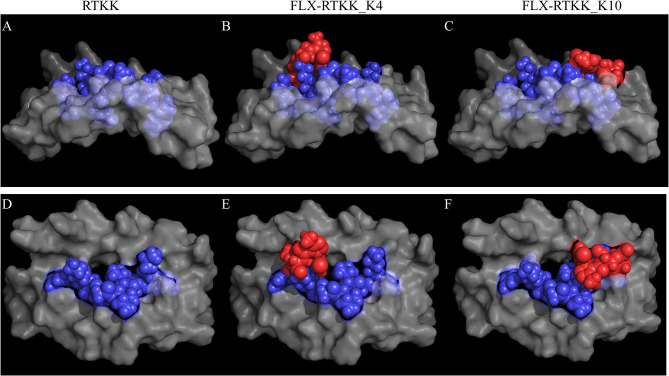

In silico prediction of the interactions of parent and flucloxacillin (FLX)-RTKK peptides with HLA-B*57:01 cleft. KAF11 peptide residues (PDB ID: 2YPK) were replaced with those of the RTKK peptide. Docking the peptide into the HLA cleft was performed using FlexPepDock and addition of the drug to the appropriate lysine and energy minimization of the structure using OpenBable (v3.0.0) software. Structures were visualized in PyMOL (v2.3.4). Lateral (A–C) and top (D–F) views of the human leukocyte antigen (HLA) complex with the unmodified parent sequence of RTKK (A, D), FLX-RTKK_K4 (B, E) and FLX-RTKK_K10 (C, F). Peptide sequences are represented in blue spheres, drug is represented by red spheres and α1α2 domains of the HLA are depicted in gray color.